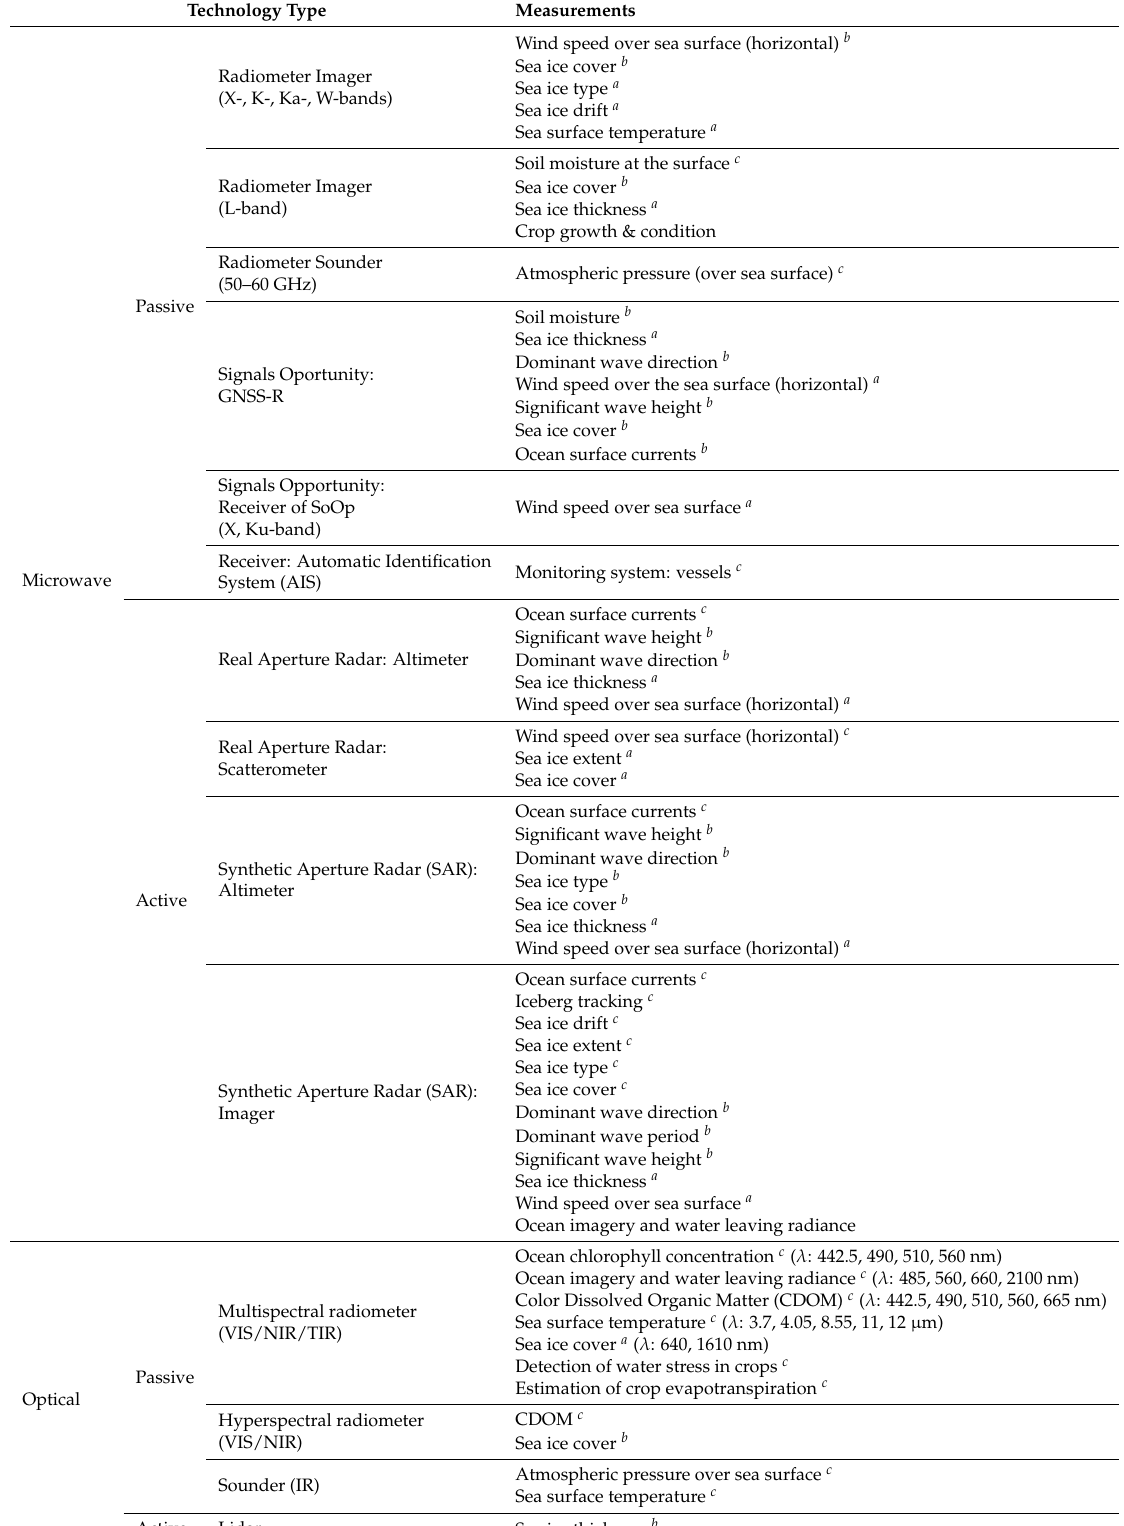
Table 5. Mapping of the potential technologies to cover measurements with